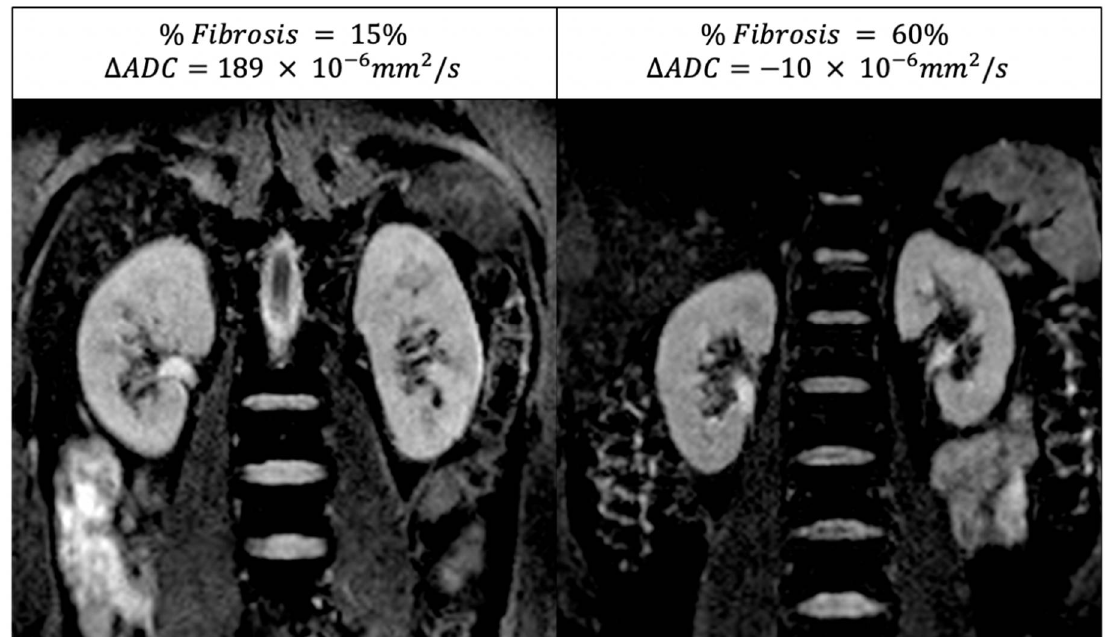
Figure 3. Example of an ADC map in two diabetic patients. On the left, the cortical ADC is higher (brighter) than the medullary ADC (positive ∆ ADC = 189 × 10 − 6 mm 2 /s) in a patient with a small amount of fibrosis (i.e., 15%) on the renal biopsy. On the right, the cortico-medullary ADC difference is lost (negative ∆ ADC = − 10 × 10 − 6 mm 2 /s) in this diabetic patient with a higher amount of renal fibrosis on the renal biopsy (60%).